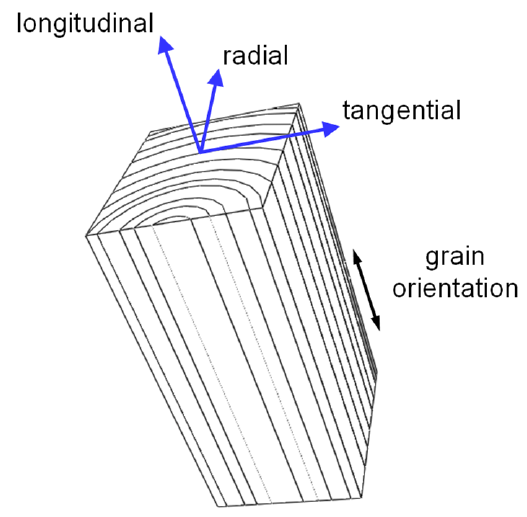
Figure 3. Orthotropic directions of